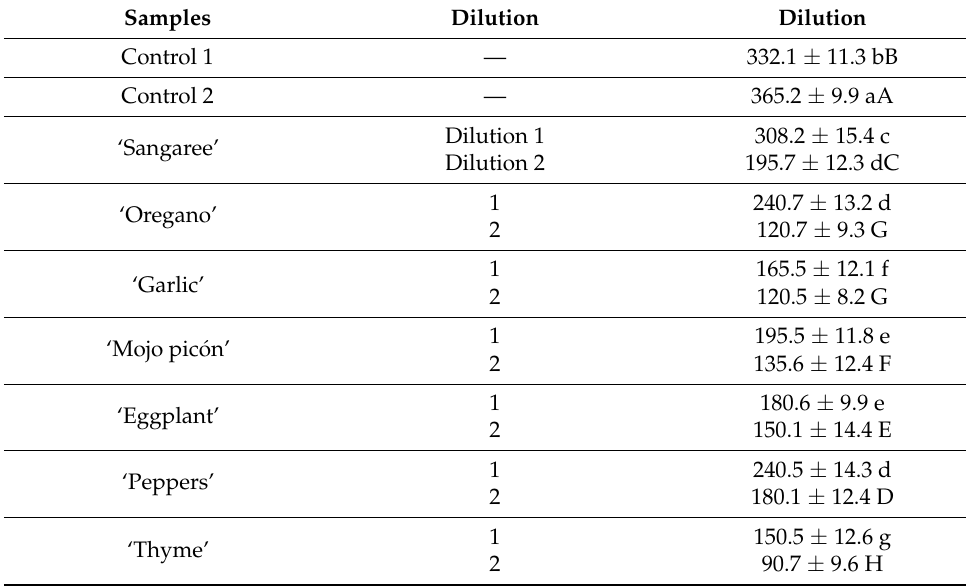
Table 3. Acrylamide concentration (ng g − 1 ) of the ‘Hojiblanca’ table olive variety stuffed with different aromatic hydrocolloids. Different lowercase letters mean a statistically significant